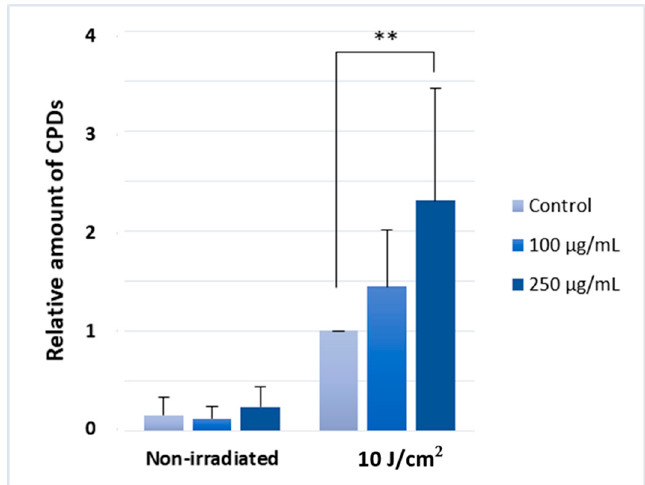
Figure 4. The relative amount of CPD photolesions after UVA irradiation and silymarin co-treatment. The results are the mean of six independent experiments. Error bars represent SD; ** indicates statistically significant difference at p < 0.01. mL and please change 0,5 1,5 2,5 as 0.5 1.5 2.5 in the Y-axis.